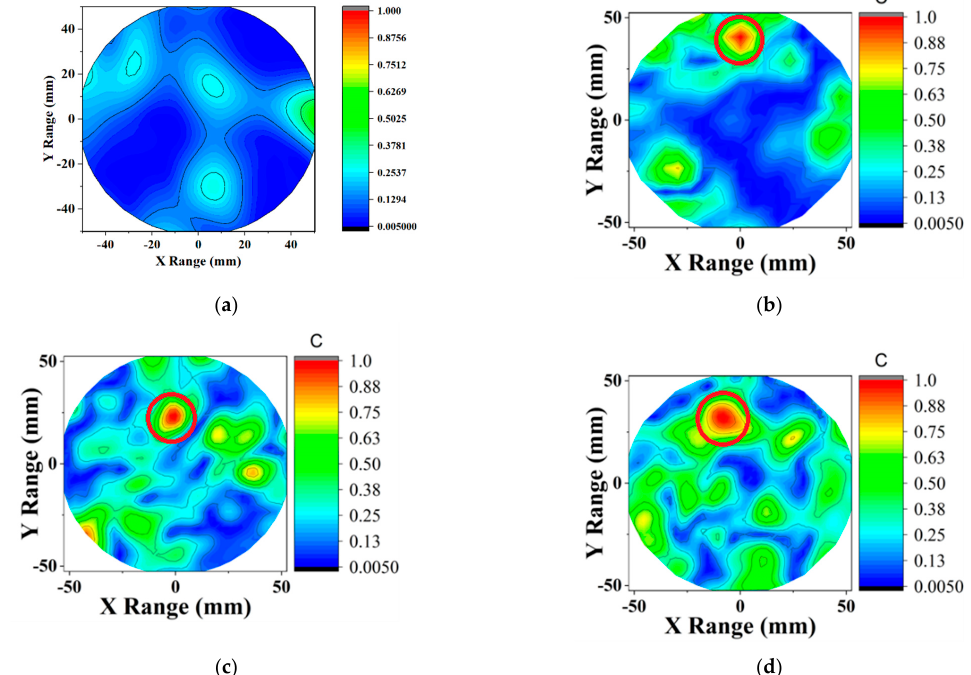
Figure 7. Contour plot of the reconstructed image of a single tumor phantom ( a ) without tumor, using ( b ) DMAS (left), ( c ) proposed CS-ICDMAS (50% compression) and ( d ) CS-ICDMAS with 75% compression.